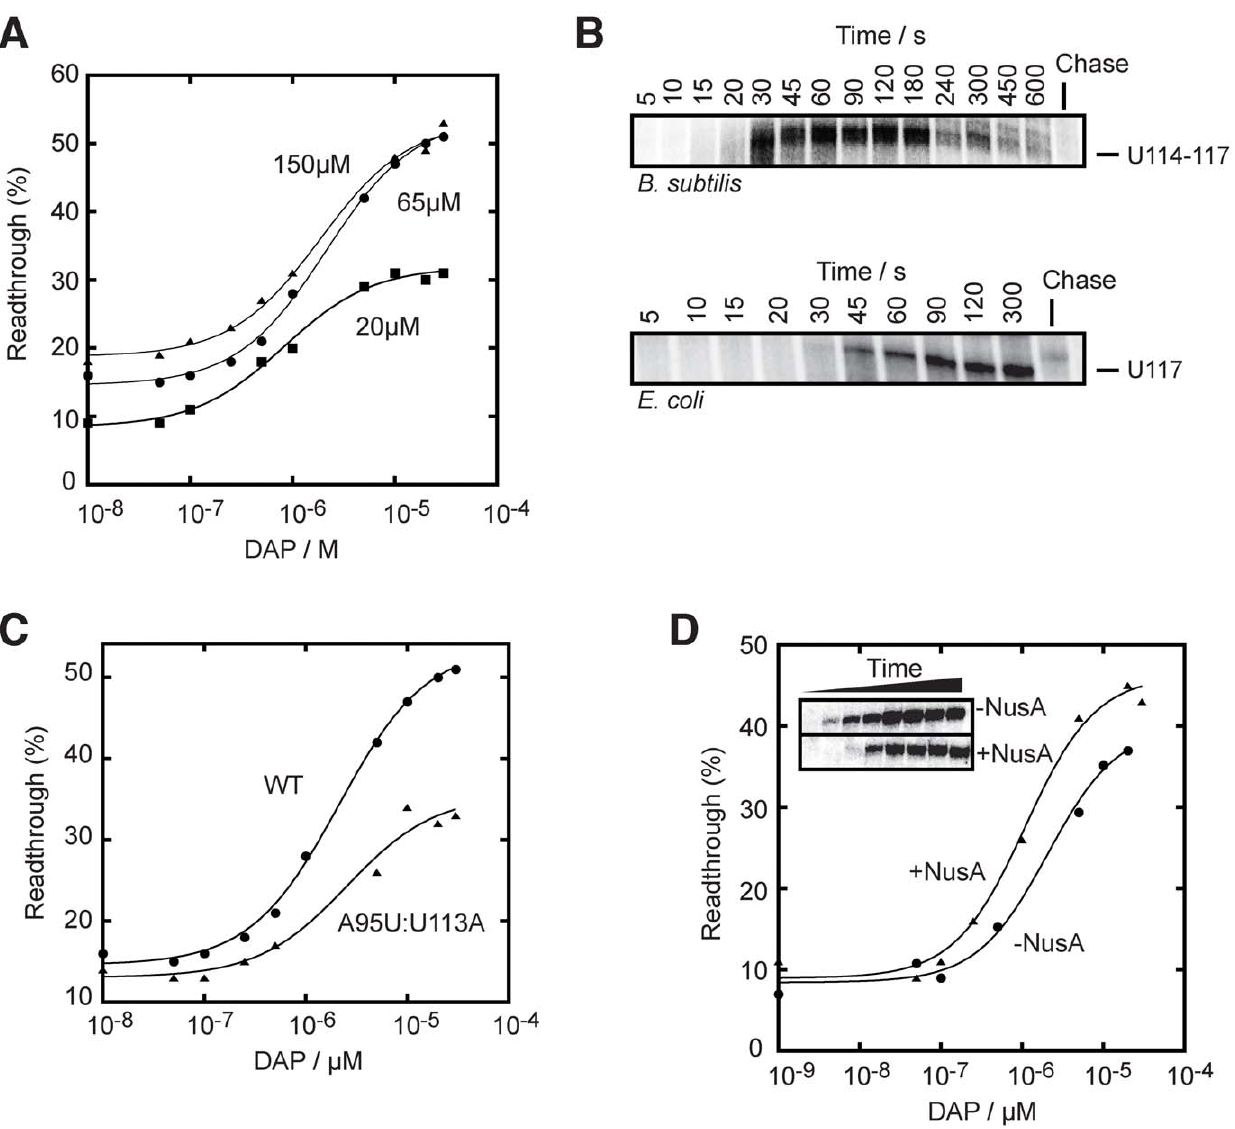
Figure 5. The rate of transcription is important for the pbuE riboswitch activity. (A) Single-round in vitro transcriptions were performed using either 20 m M (squares), 65 m M (circles) or 150 m M (triangles) rNTP. T 50 values of 0.8 6 0.1 m M, 2.1 6 0.2 m M and 1.9 6 0.3 m M were obtained for reactions using 20 m M, 65 m M and 150 m M rNTP, respectively. (B) Single-round transcription kinetics were performed and stopped at various time intervals. The complete gel is shown in Figure S5. Top, transcription time course showing a pausing site in the region U114–U117 that is observed when using the B. subtilis RNAP. Bottom, transcription time course performed with the E. coli RNAP also reveals a pausing site at position U117. Chase reactions were performed using 150 m M rNTP. (C) Single-round transcriptions using an A95U:U113A mutant that disrupts the riboswitch regulation. A T 50 value of 2.6 6 0.1 m M was calculated. The readthrough efficiency is also significantly decreased in the context of the mutant (triangles). (D) Single- round experiments were performed in absence (circles) and in presence (triangles) of 1 m M NusA. T 50 values of 2.1 6 0.7 m M and 1.1 6 0.3 m M were obtained in absence and in presence of NusA, respectively. The insert shows transcription kinetics done for 5, 10, 15, 20, 30, 45, 60 and 300 s in absence and in presence of 1 m M NusA. It can be observed that the presence of NusA delays the appearance of the full length species (15 s to 20 s), consistent with its role in slowing down transcription.